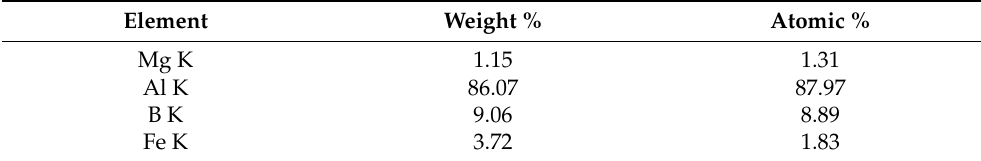
Figure 17. EDX analysis spectrum at point C in specimen welded in inert conditions. Table 13. EDX quantitative analysis data at point C in specimen welded in inert